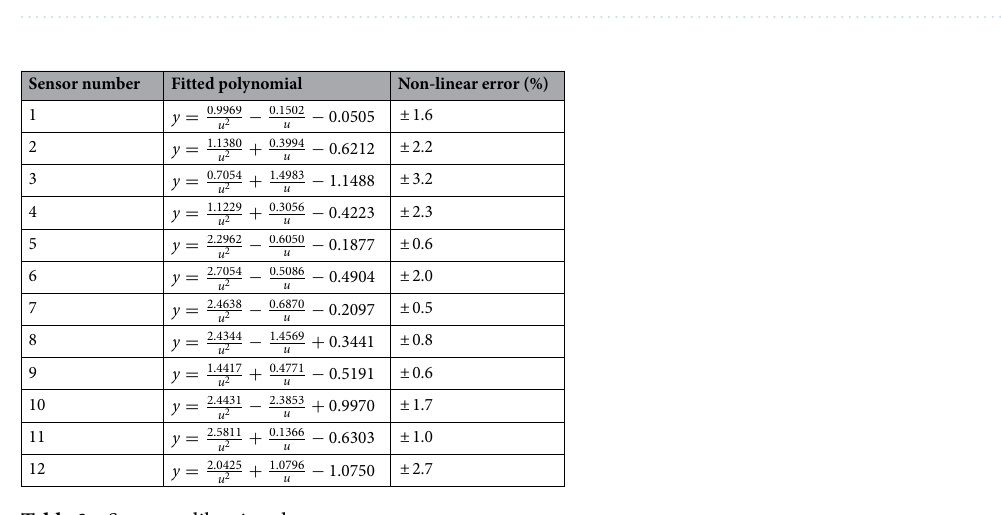
Table 3. Sensor calibration